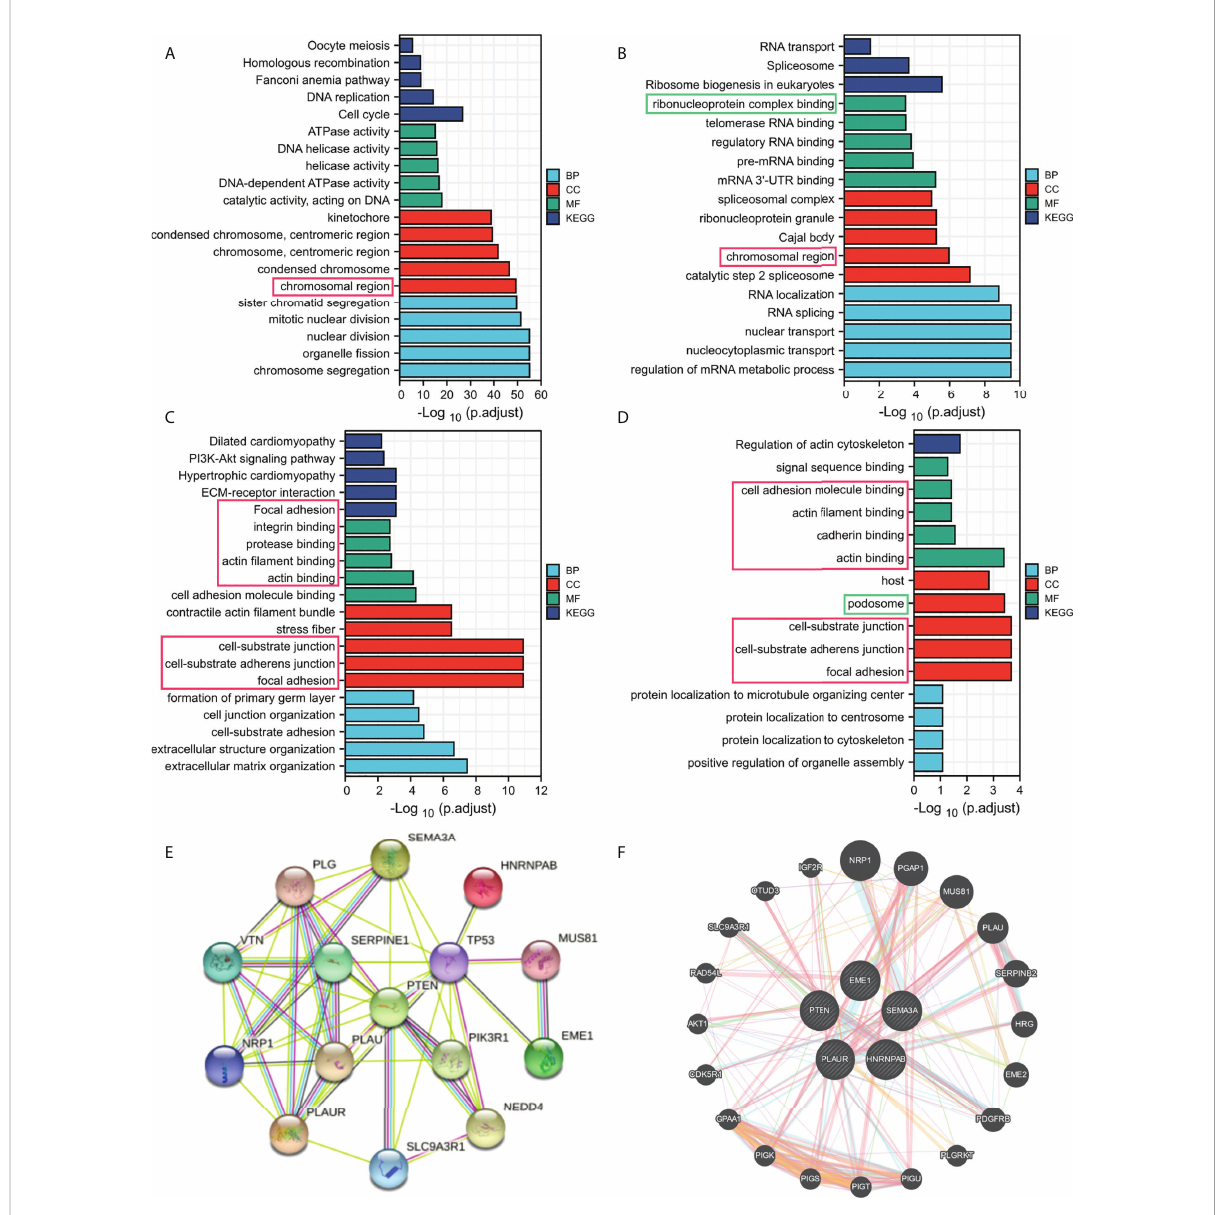
FIGURE 7 Functional enrichment analysis of the predicted target genes. (A) EME1. (B) HNRNPAB. (C) PLAUR. (D) SEMA3A. (E) The PPI network map. (F) Functional association